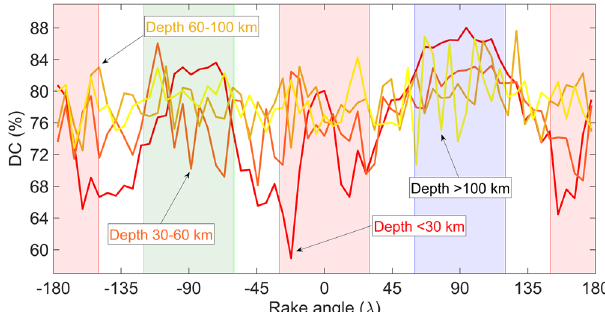
Fig. 4 Trends of double-couple component of the seismic moment tensors in the GCMT catalogue (M w ≥ 5.3, 1990 – 2021) for different ranges of hypocentral depth. The red line represents DC values for seismicity shallower than 30 km, while the orange one stands for events in between 30 and 60 km, the salmon one is the trend of 60 – 100 km and the yellow line for deep earthquakes (>100 km). Error bars are not plotted for the sake of readability; however, their size has the same order of magnitude of those in Fig. 1, usually larger for deeper